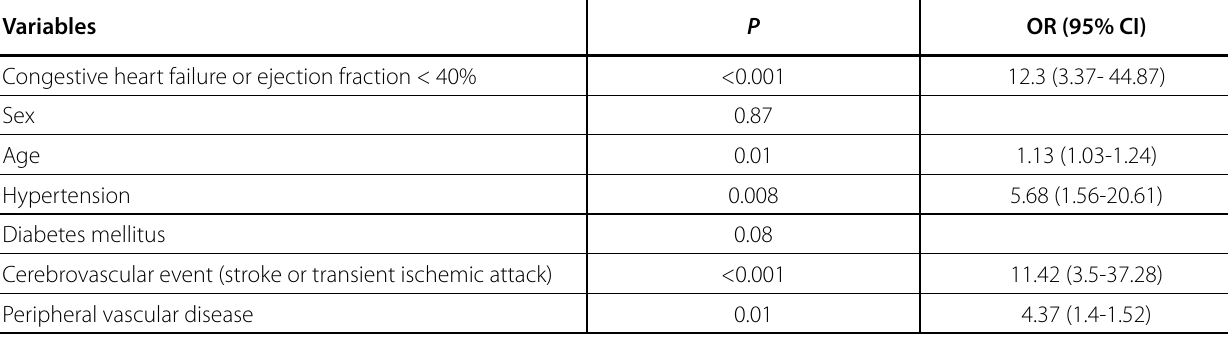
DS -Vasc score component for MACE. 2 2